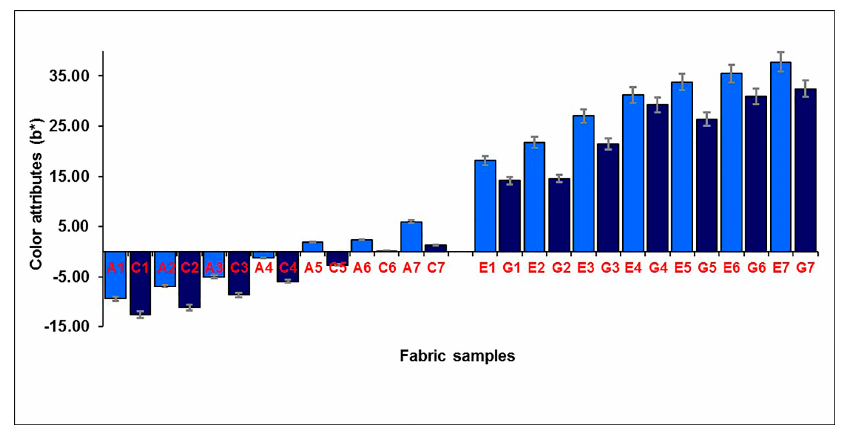
Figure 8. Effect of weft-backed structure on the blueness and yellowness of blue-red and yellow-green mixed fabrics.